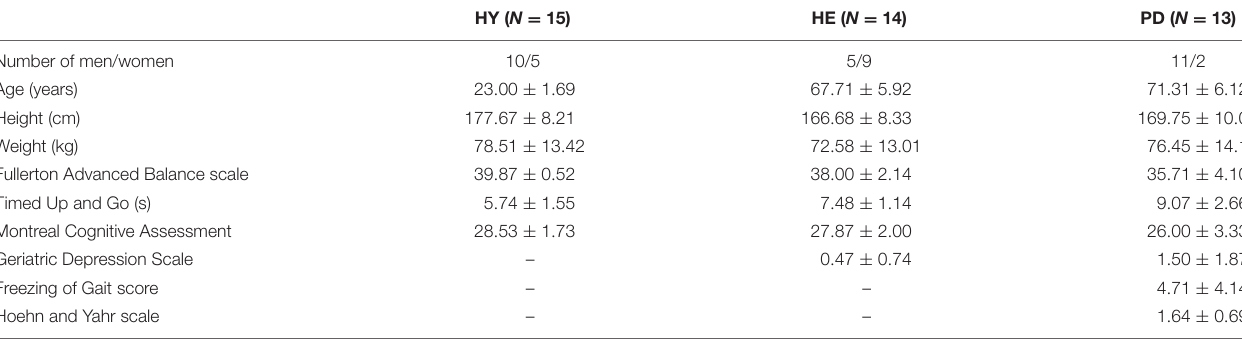
TABLE 1 | Demographic and clinical characteristics of